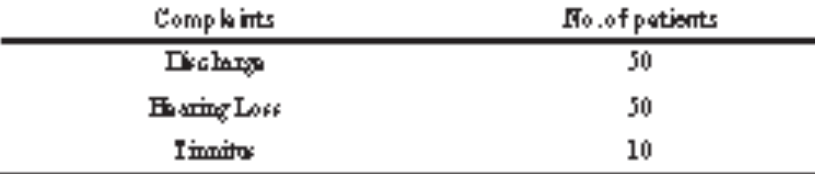
Table II : Chief Complaints (n=50)